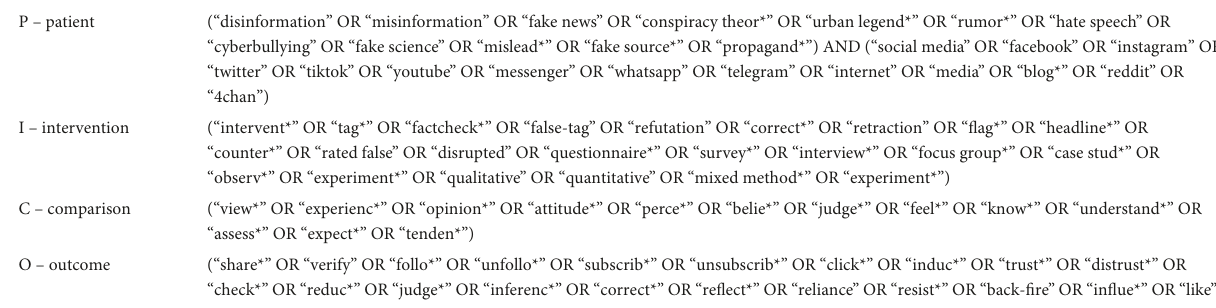
TABLE 3 Patient, Intervention, Comparison, and Outcome (PICO) search strategy